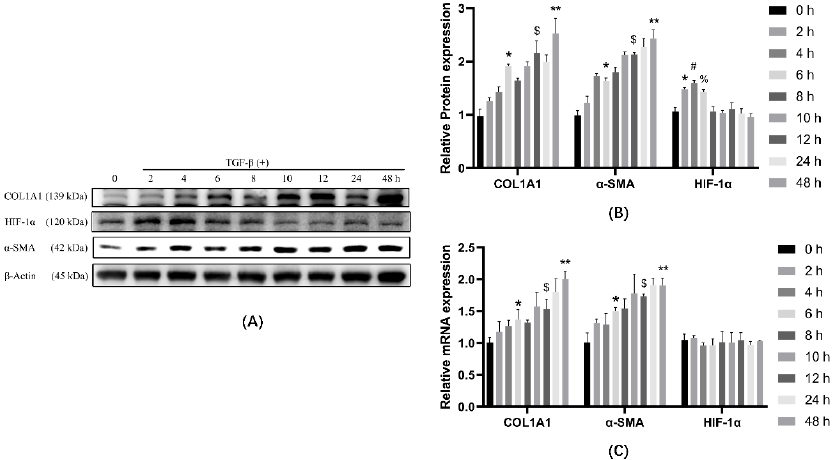
Figure 2. The effect of TGF- β 1 on cell transdifferentiation was analyzed by comparing the expression of COL1A1, HIF-1 α , and α -SMA using TGF- β 1-treated cells for different times. ( A ) Western blot analysis of COL1A1, HIF-1 α , and α -SMA in cells of different groups. β -actin was used as a loading control. ( B ) Quantitative analysis of COL1A1, HIF-1 α , and α -SMA is shown in Figure 2A. ( C ) Cells were treated with TGF- β 1 at different times, and mRNA was extracted from the treated groups. mRNA expression was determined by qPCR and normalized to β -actin. * p < 0.05 vs. 0 h group; # p < 0.05 vs. 2 h group; % p < 0.05 vs. 4 h group; $ p < 0.05 vs. 6 h group; ** < 0.05 vs. 12 h group. ANOVA was used to compare multiple groups and pairwise comparisons were compared by LSD-